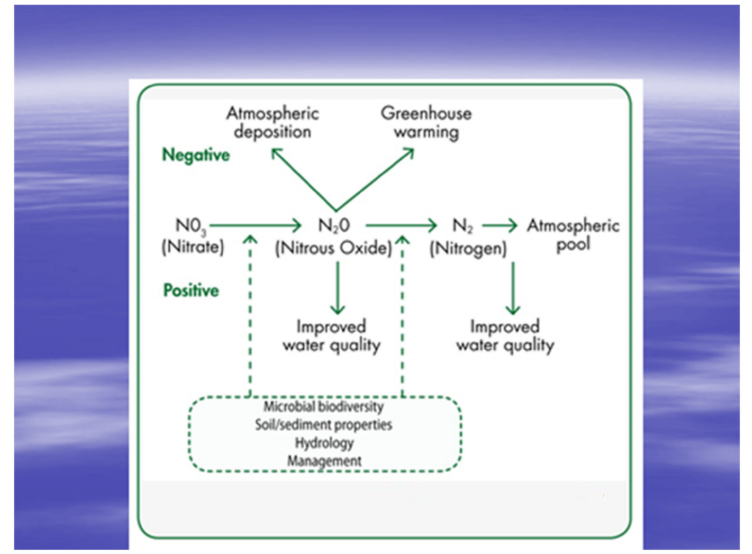
Figure 32. Example of trade-offs between water quality maintenance and global warming